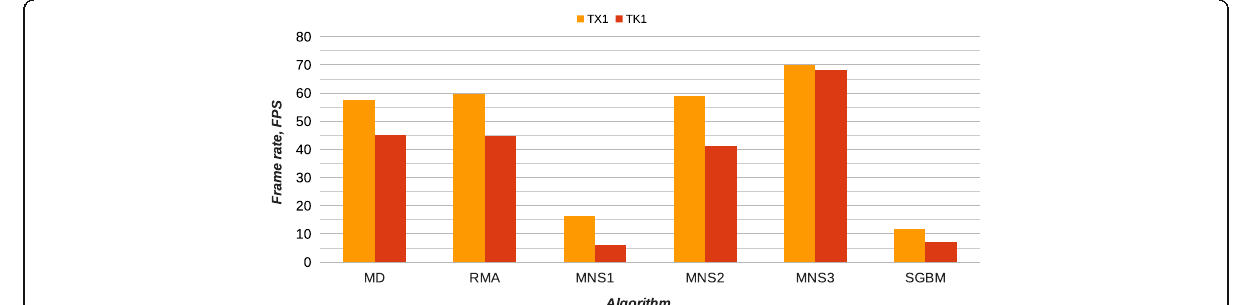
Fig. 8 Performance comparison of Jetson TX1 and Jetson TK1 boards. Evaluated on the Q resolution training set. TX1 processing frame rate was always higher than